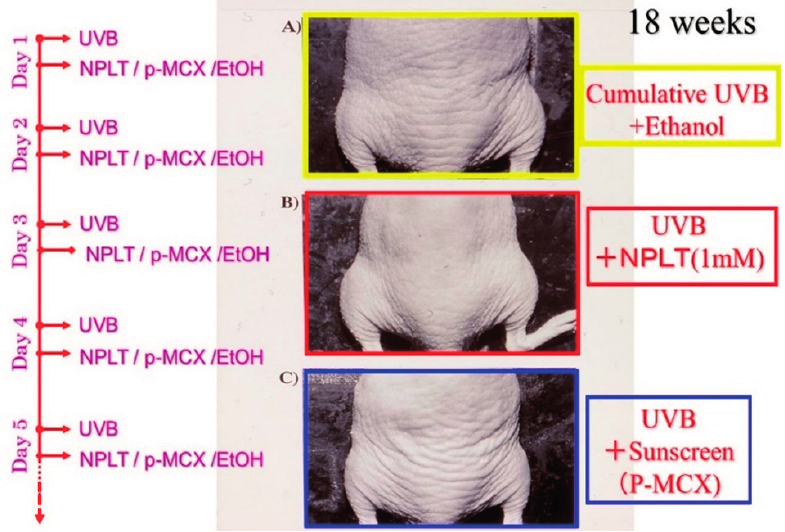
Figure 9. Photographs of wrinkle formation on the dorsal skin of hairless mice at week 18. ( A ) UVB-exposed and 80% ethanol–treated skin; ( B ) UVB-exposed and NPLT-treated skin; ( C ) UVB-exposed and Parsol-MCX–treated skin. The UVB radiation was carried out in